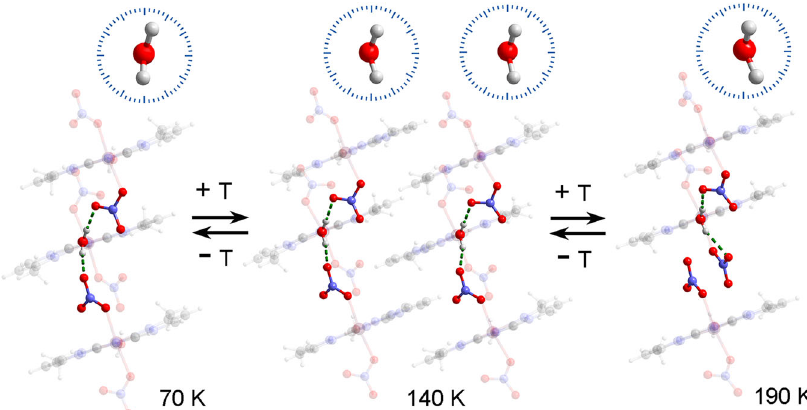
Fig. 3 Variations in the orientation of the water molecule in complex 1. The coordinated water molecule undergoes a reversible two-step rotation in response to the temperature, which can be induced by the direction of the hydrogen bonds, O – H···O, between the water and nitrates after the structural phase transition. The top images show the orientations of the water molecule at each temperature, where the corresponding dihedral angle, φ , changes from 61.71° at 70 K to 70.66° and 68.19° at 140 K, and to 85.30° at 190 K. Maroon, Co; gray, C; blue, N; red, O; light gray,